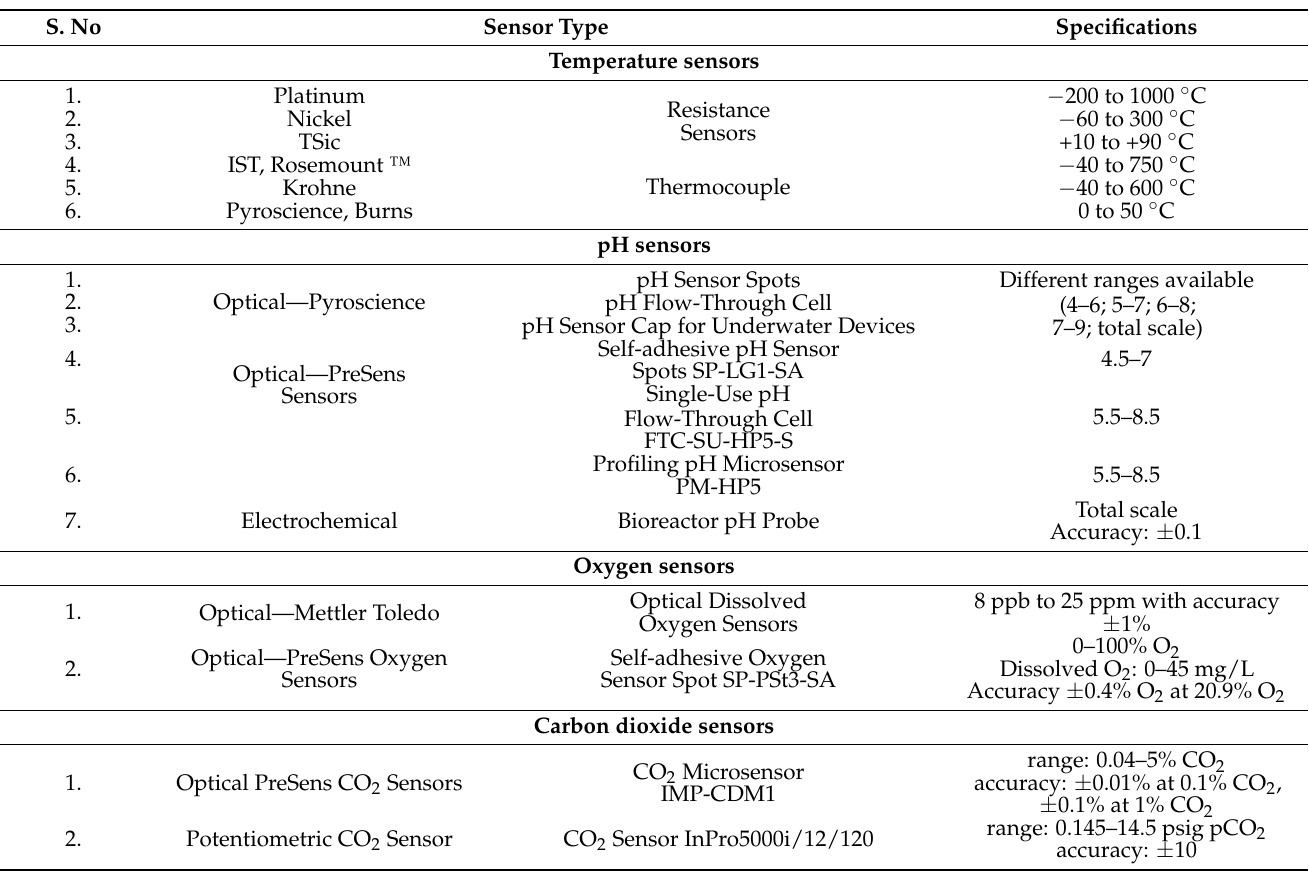
Table 1. Sensors adopted for monitoring the physio-chemical conditions in the tissue engineering [129]. S.